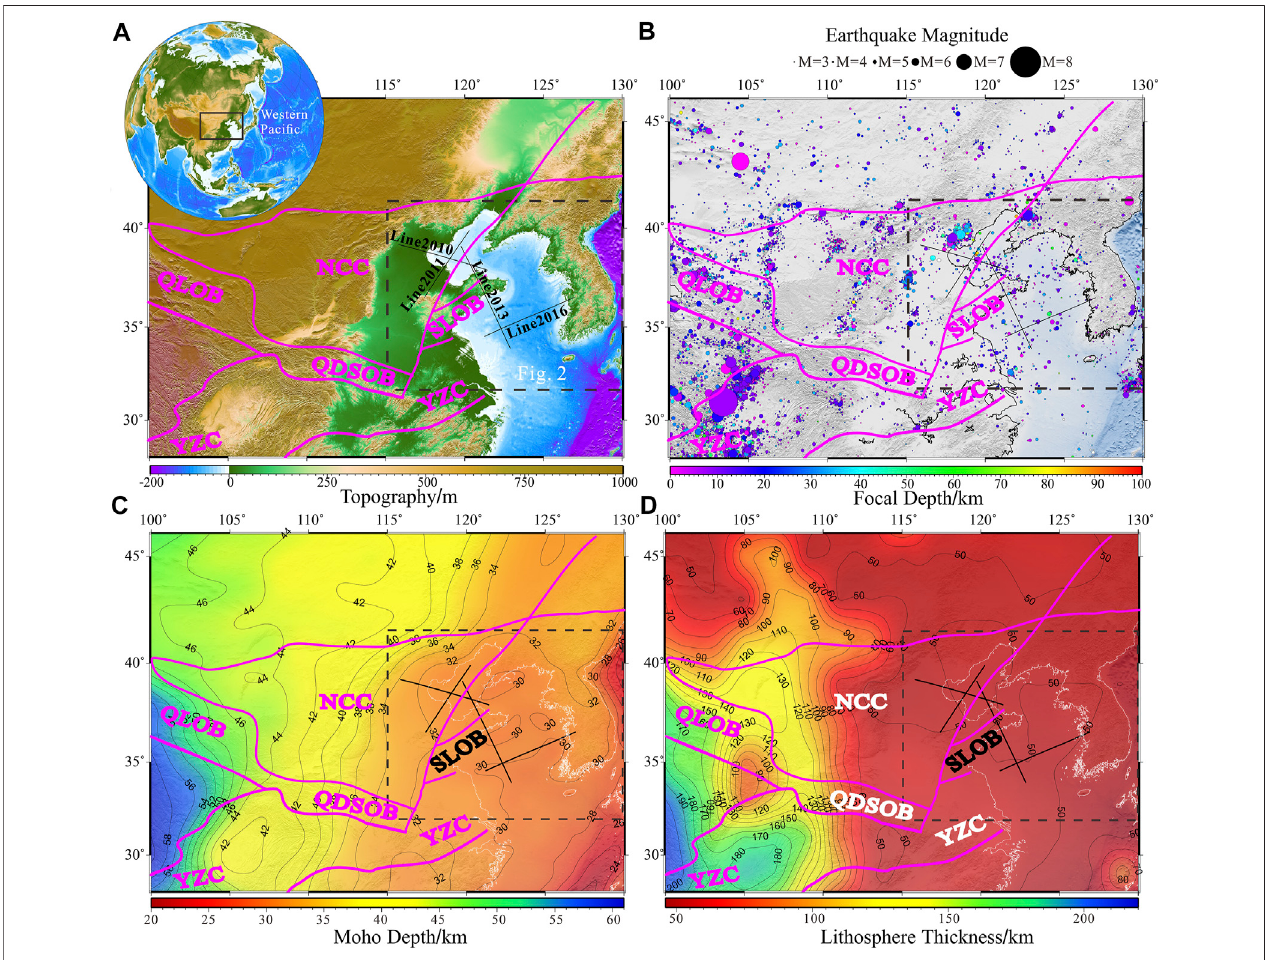
FIGURE 1 | (A) Topography of North China locating in the black box in the upper left insert map. (B) Seismicity with magnitude larger than 3 in North China from 1960sto 2021 (the earthquake events catalog was downloaded from IRIS: https://ds.iris.edu/ds/nodes/dmc/data/types/events/). (C) Moho depth ofNorth China (after Haoetal.,2014). (D) LithospherethicknessofNorthChina(afterSunetal.,2021).ThetectonicunitsareannotatedinFigure (A – D) ,thestudyarea( Figure2 )ofthispaper is located in the black dashed boxes of Figure (A – D) . The black solid lines are active-source wide-angle seismic survey lines deployed by us from 2010 to 2016 in the study area (Liu et al., 2015; Liu et al., 2021). QLOB, qilian orogenic belt; QDSOB, qinglin-dabie-sulu orogenic belt; SLOB, sulu orogenic belt.